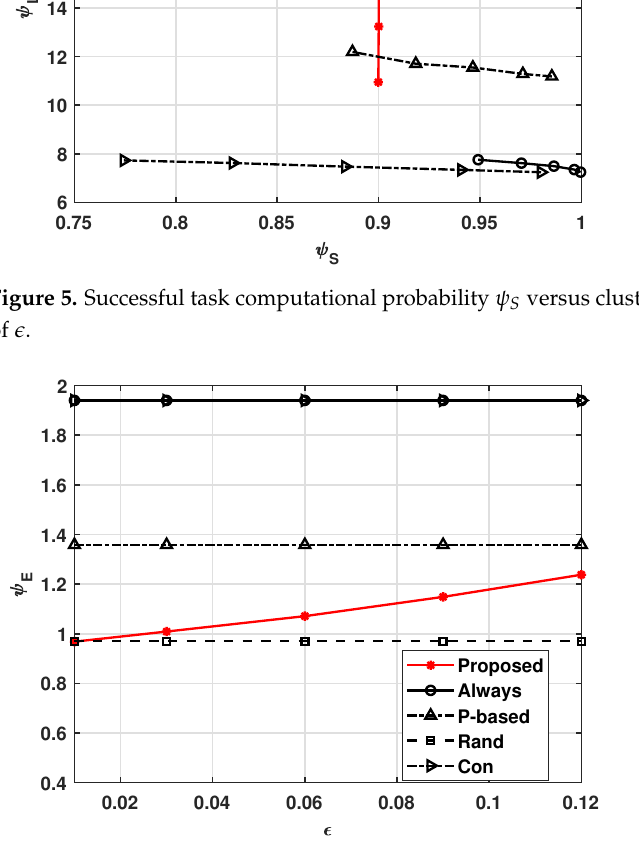
Figure 6. Average energy consumption ψ E versus (cid:101) Tx , where (cid:101) Rx = 0.06.